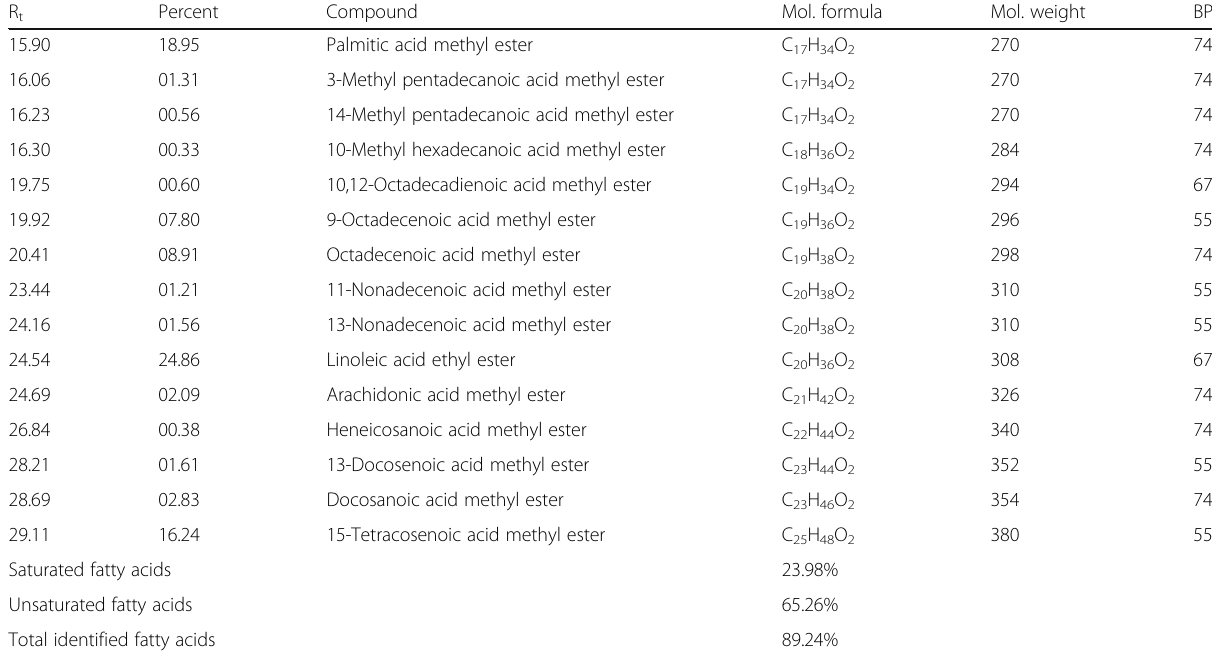
Table 3 GC ∕ MS of the saponifiable matter of P . ovata seeds